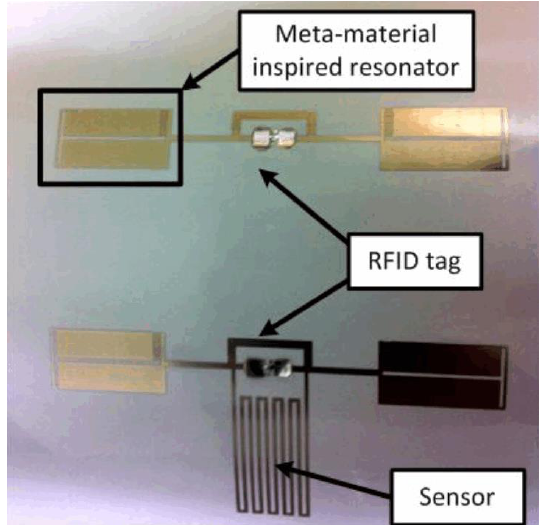
Figure 1. Inkjet-printed capacitive sensor [44].